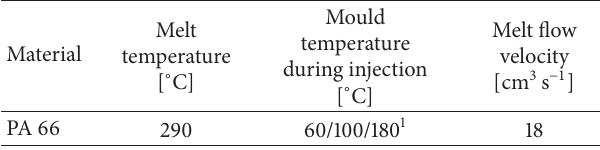
Table 2: Processing